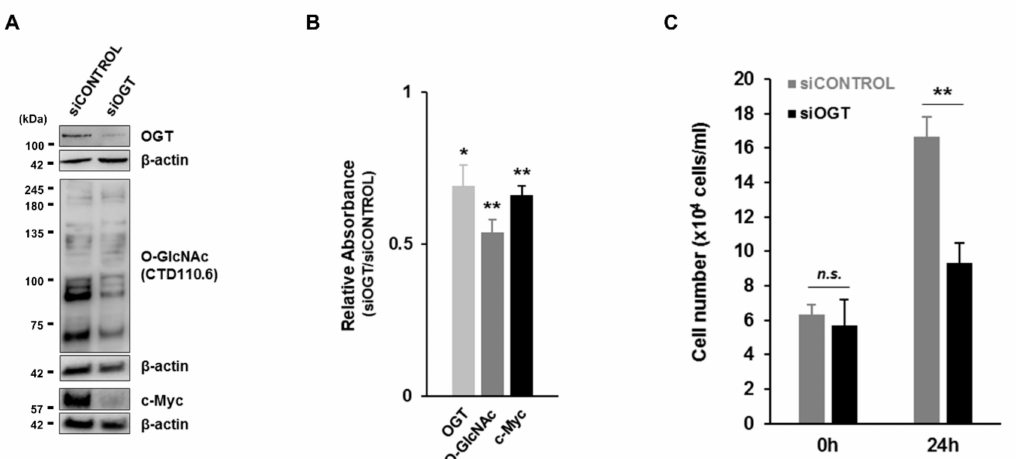
Figure 6. Suppressed O-GlcNAcylation in pre-B cells by OGT knockdown causes decreased cell proliferation via reduction of c-Myc expression. ( A ) Representative western blot to monitor changes in OGT, c-Myc, and overall O-GlcNAc levels in PD36 pre-B cells transfected with siOGT for 24 h compared to siCONTROL. ( B ) Relative absorbance measured using ELISA for total OGT (0.125 mg / mL), c-Myc (0.125 mg / mL), and O-GlcNAc (4 µ g / mL) protein levels in di ff erent concentrations of lysate of PD36 pre-B cell transfected with siOGT for 24 h compared to siCONTROL. Data are represented as mean ± SD ( n = 3). Comparisons between siCONTROL and siOGT. ( C ) Cell growth with knock-down of OGT was checked at 24 h compared to control cells. Data are represented as mean ± SD ( n = 3). Comparisons were performed for cell numbers between siCONTROL and siOGT. ( B , C ) Significance is annotated as * p ≤ 0.05, ** p ≤ 0.01. n.s. = not